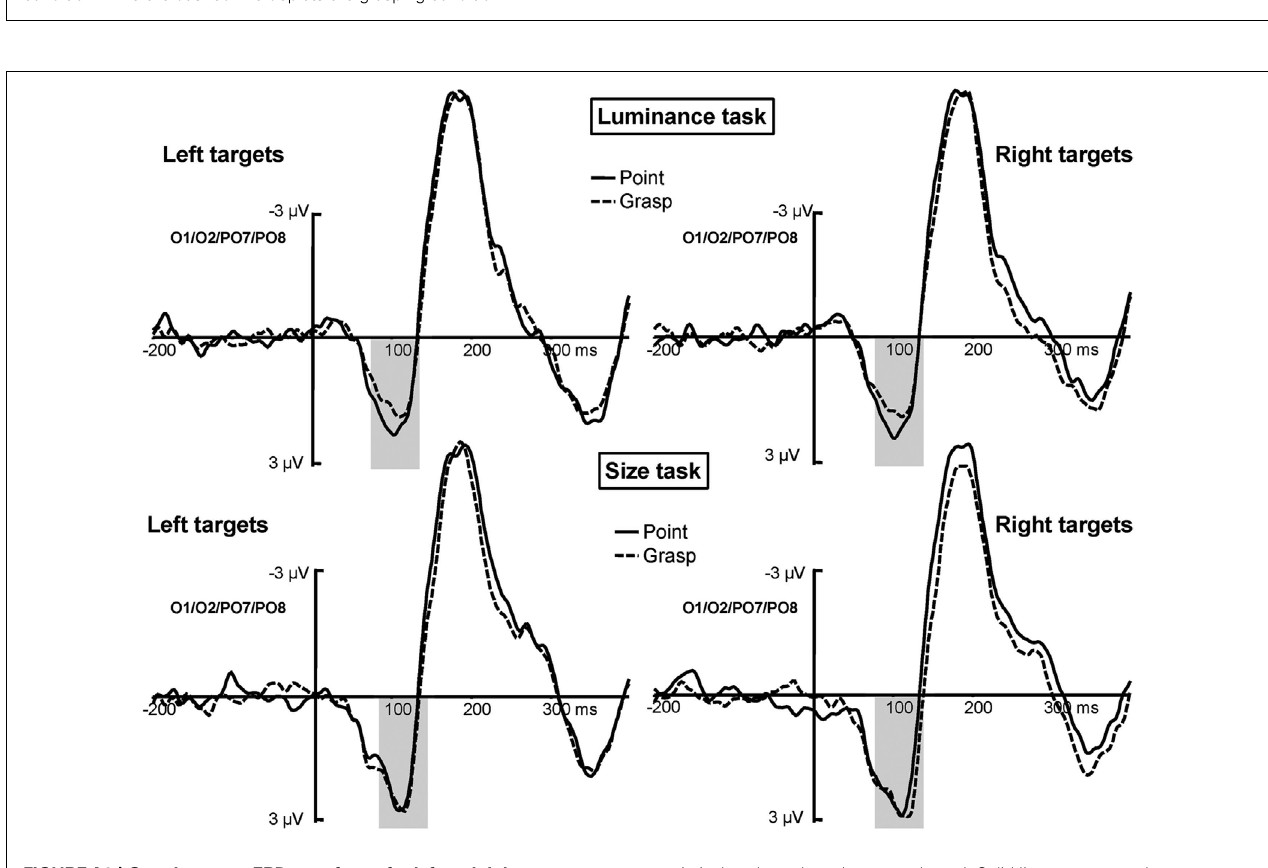
FIGUREA2 | Grand average ERP waveforms for left and right targets separately in the luminance and size task conditions. The dark gray box depicts the P1 time window (70–130ms) for which